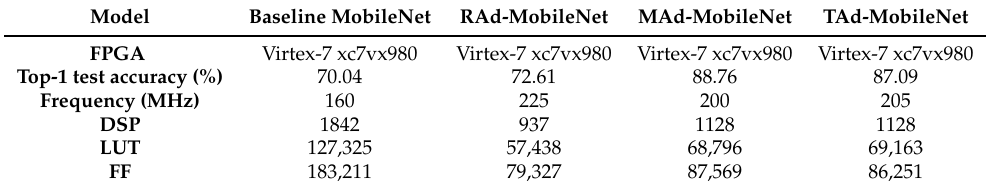
Table 5. Performance comparison of the baseline MobileNet and the Ad-MobileNet models on